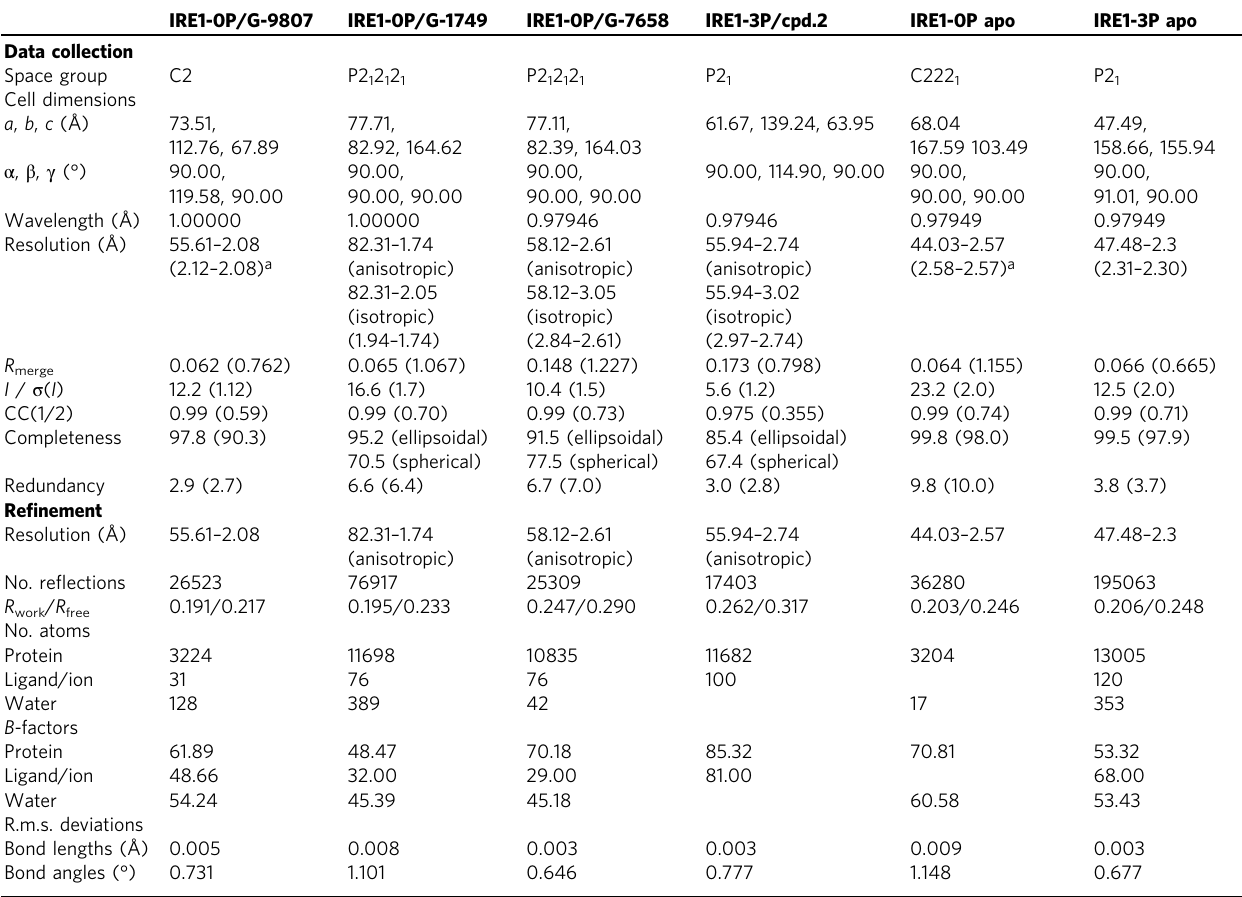
a Values in parentheses are for highest-resolution